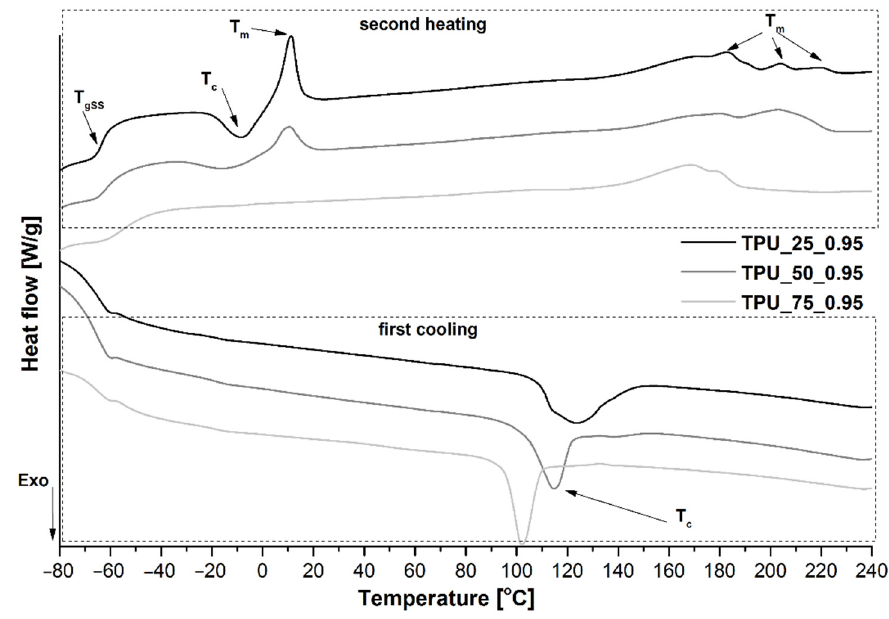
Figure 5. The endothermic (2nd run) and exothermic (1st run) curves of synthesized TPUs at the [NCO]/[OH] molar ratio 0.95. Table 3. Thermal properties of synthesized TPUs determined by DSC technique.